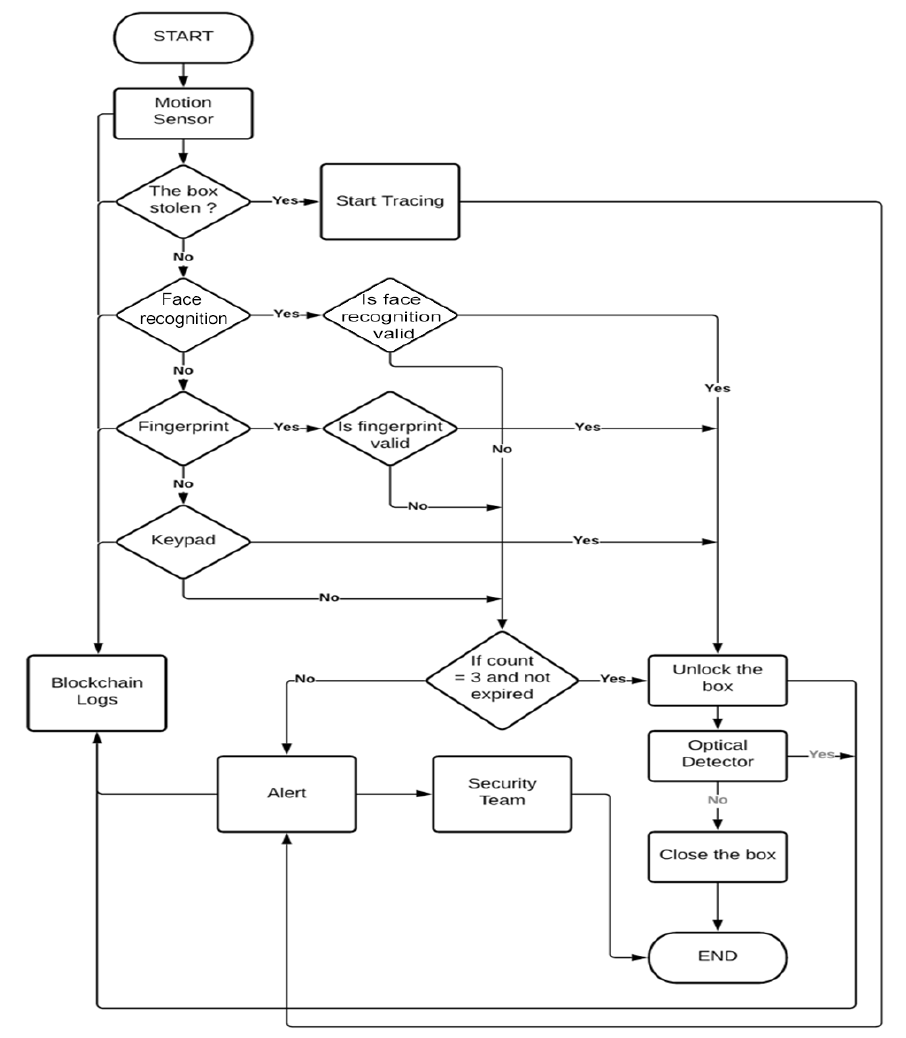
Figure 2 . Smart Safe Box Flow Chart. Figure 2. Smart Safe Box Flow